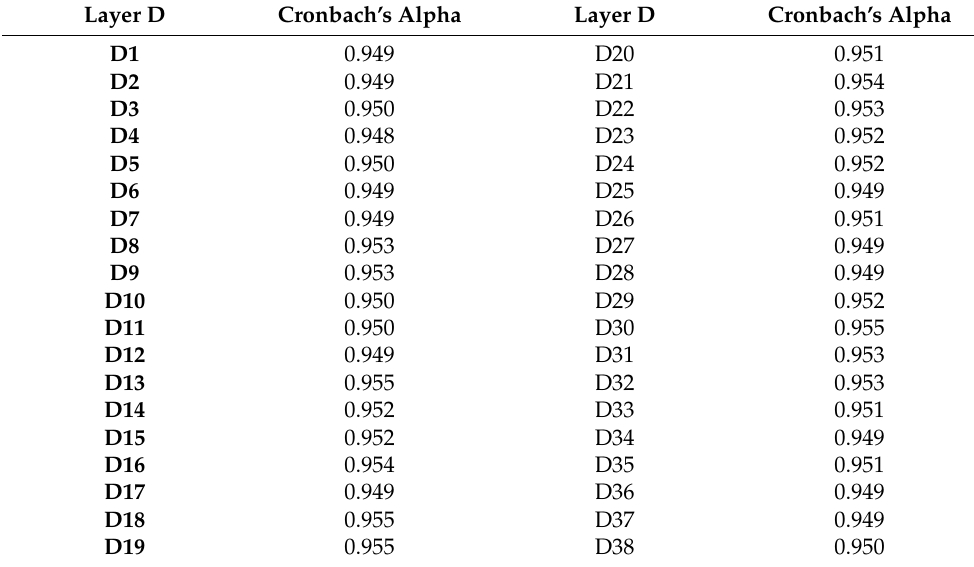
Table 4. Comprehensive evaluation index result.